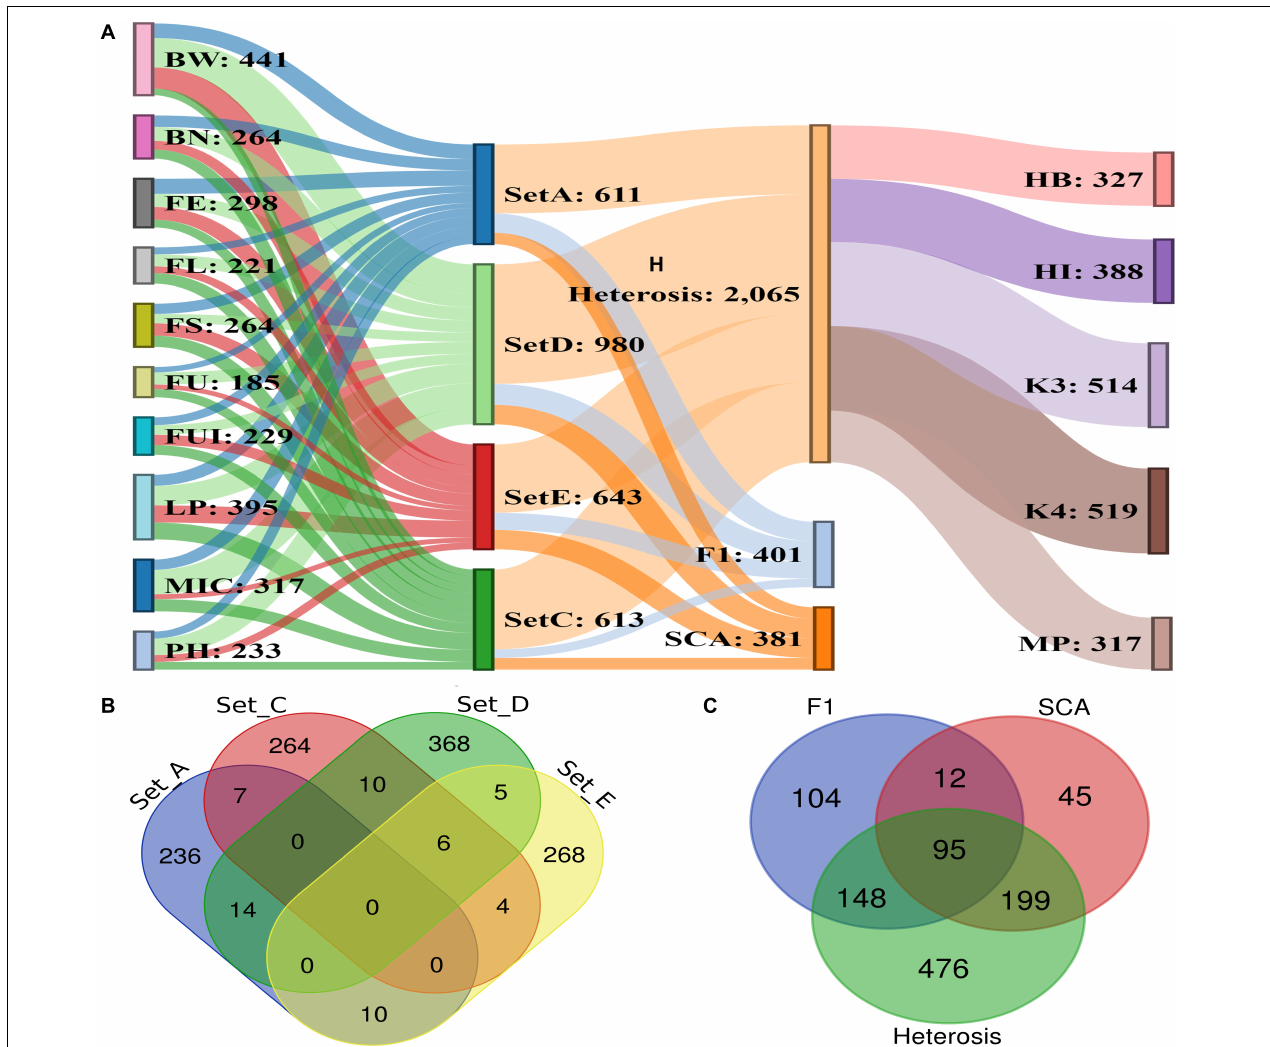
FIGURE 6 | Summary of significant association signals and significant SNPs. (A) Representation of significant associations among 10 phenotypic traits, four F 1 sets, five heterosis types, SCA and significant SNPs (B) details of significant SNPs commonly associated across four different sets of F 1 hybrids (C) number of significant SNPs/hQTNs associated with heterosis types, SCA and F 1